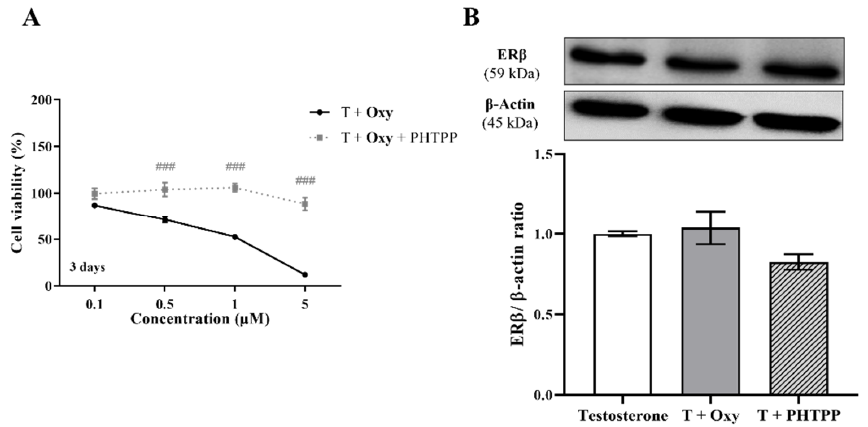
Figure 7. Involvement of ER β in the effects induced by Oxy on breast cancer cells. ( A ) Effects of Oxy (0.1–5 µ M) on viability of MCF-7aro cells stimulated with T (1 nM) and treated with or without PHTPP (1 μ M) after 3 days. ( B ) Effects of Oxy (1 μ M) on the expression levels of ER β protein